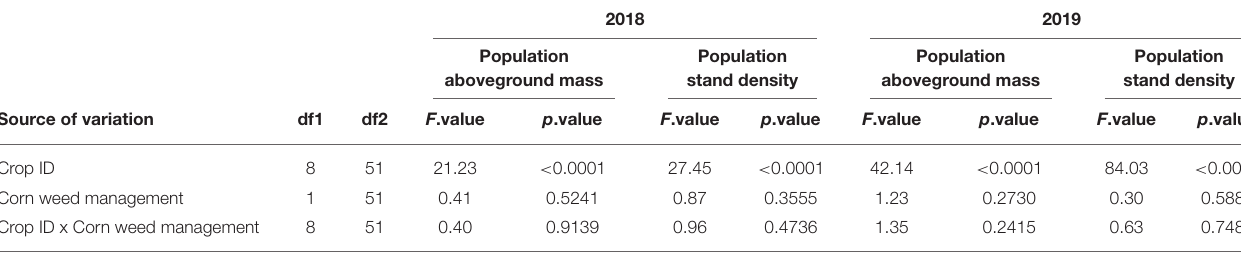
TABLE 4 | ANOVAs of crop identity and corn weed management effects on waterhemp population aboveground mass and stand density.